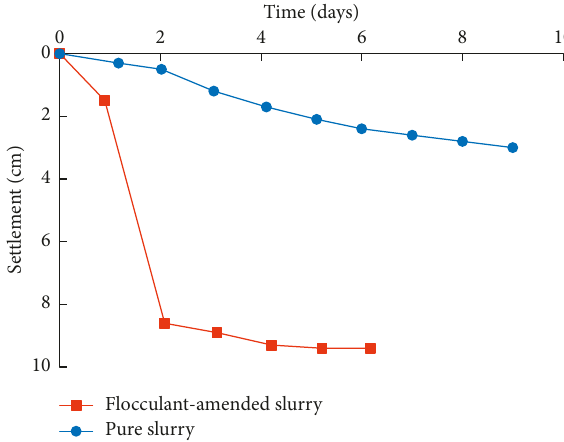
Figure 10: Settlement versus time in the geotextile tube test.